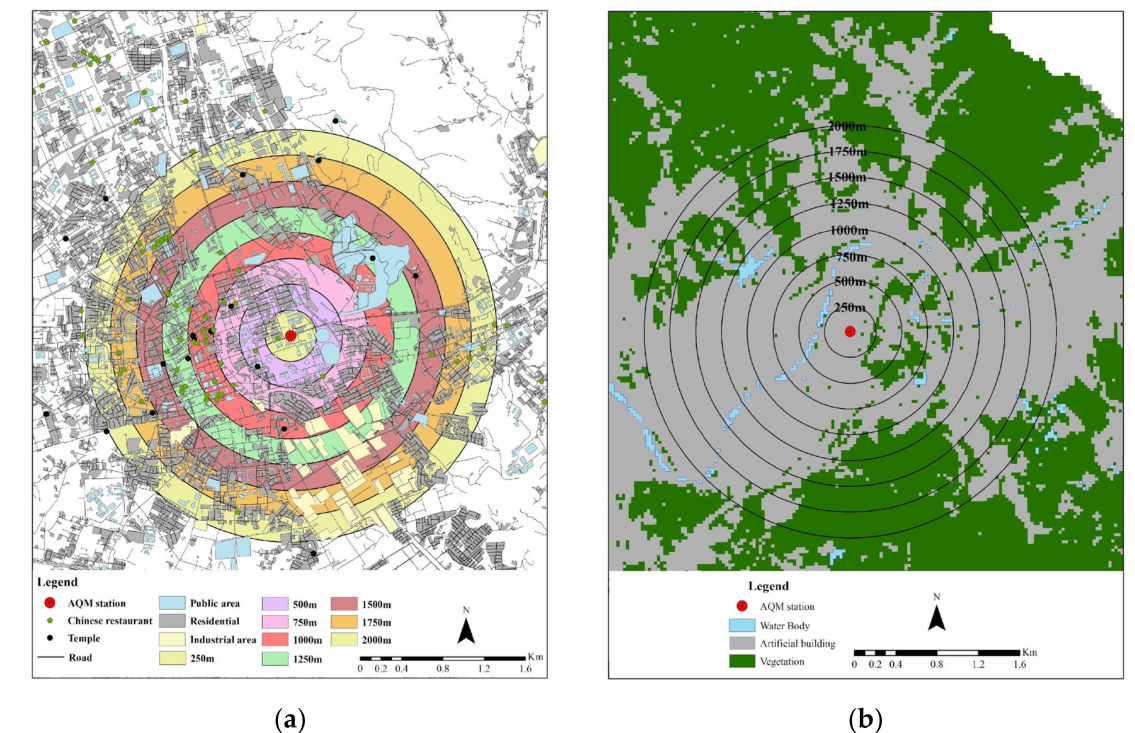
Figure 2. Buffering analyses with a radius that ranges from 250 m to 2000 m within Taipei Metropolis. ( a ) Buffering analyses using the potential predictors from a geographic dataset. ( b ) Buffering analyses using satellite image